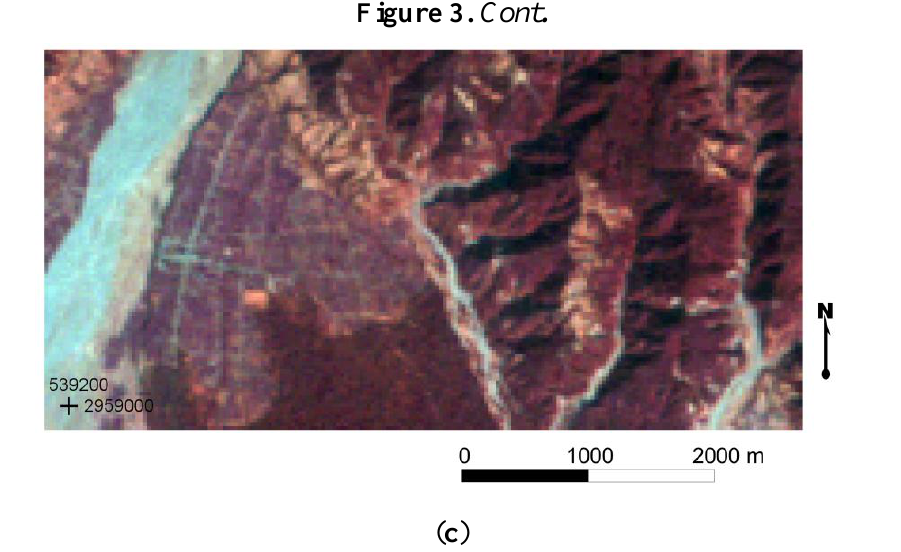
Figure 4. Distributions of KHAT statistic values at different k values in the western (upper figure) and eastern (lower figure) parts of Terai. In the boxplot, the grey region is the